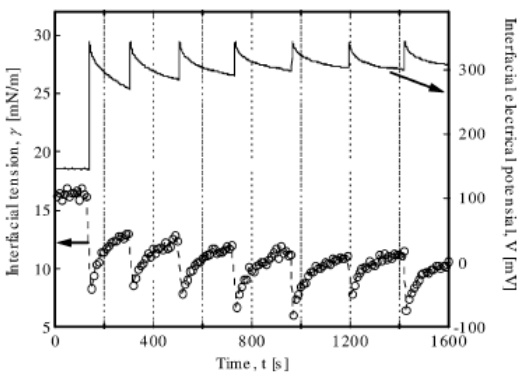
Synchronous spontaneous oscillations of interfacial tension and electrical potential between water and nitrobenzene accompanying the supply of SDS solution (10 mM) through the tip of a syringe situated at 8 mm from the water/nitrobenzene